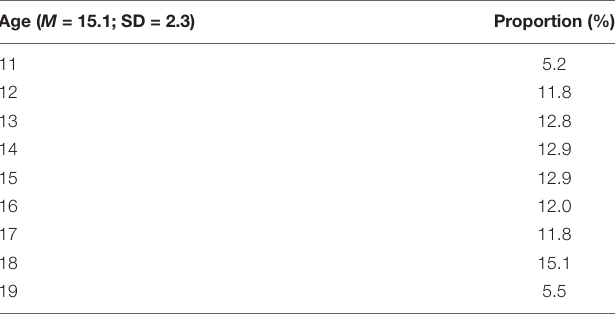
TABLE 1 | The age distribution of the